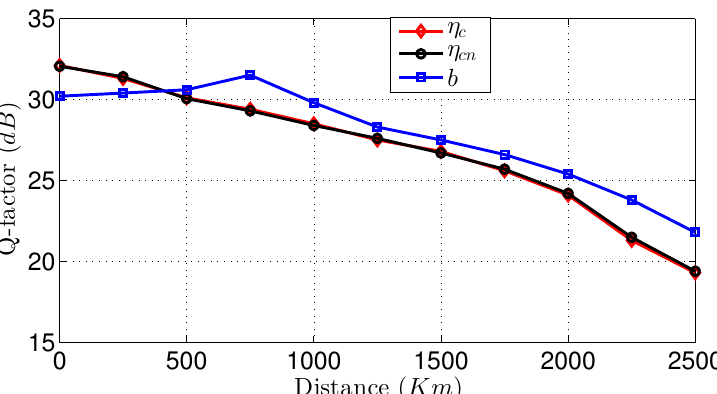
Figure 7. Q-factor versus transmission distances for all three modulations for a 50 Gbaud QPSK modulation. In blue line is shown the b-modulation, in black line, we show the modulation with a normalized reflection coefficient η c , n given in Equation (64), and in red line, the normal modulation with reflection coefficient η c , n , given in Equation